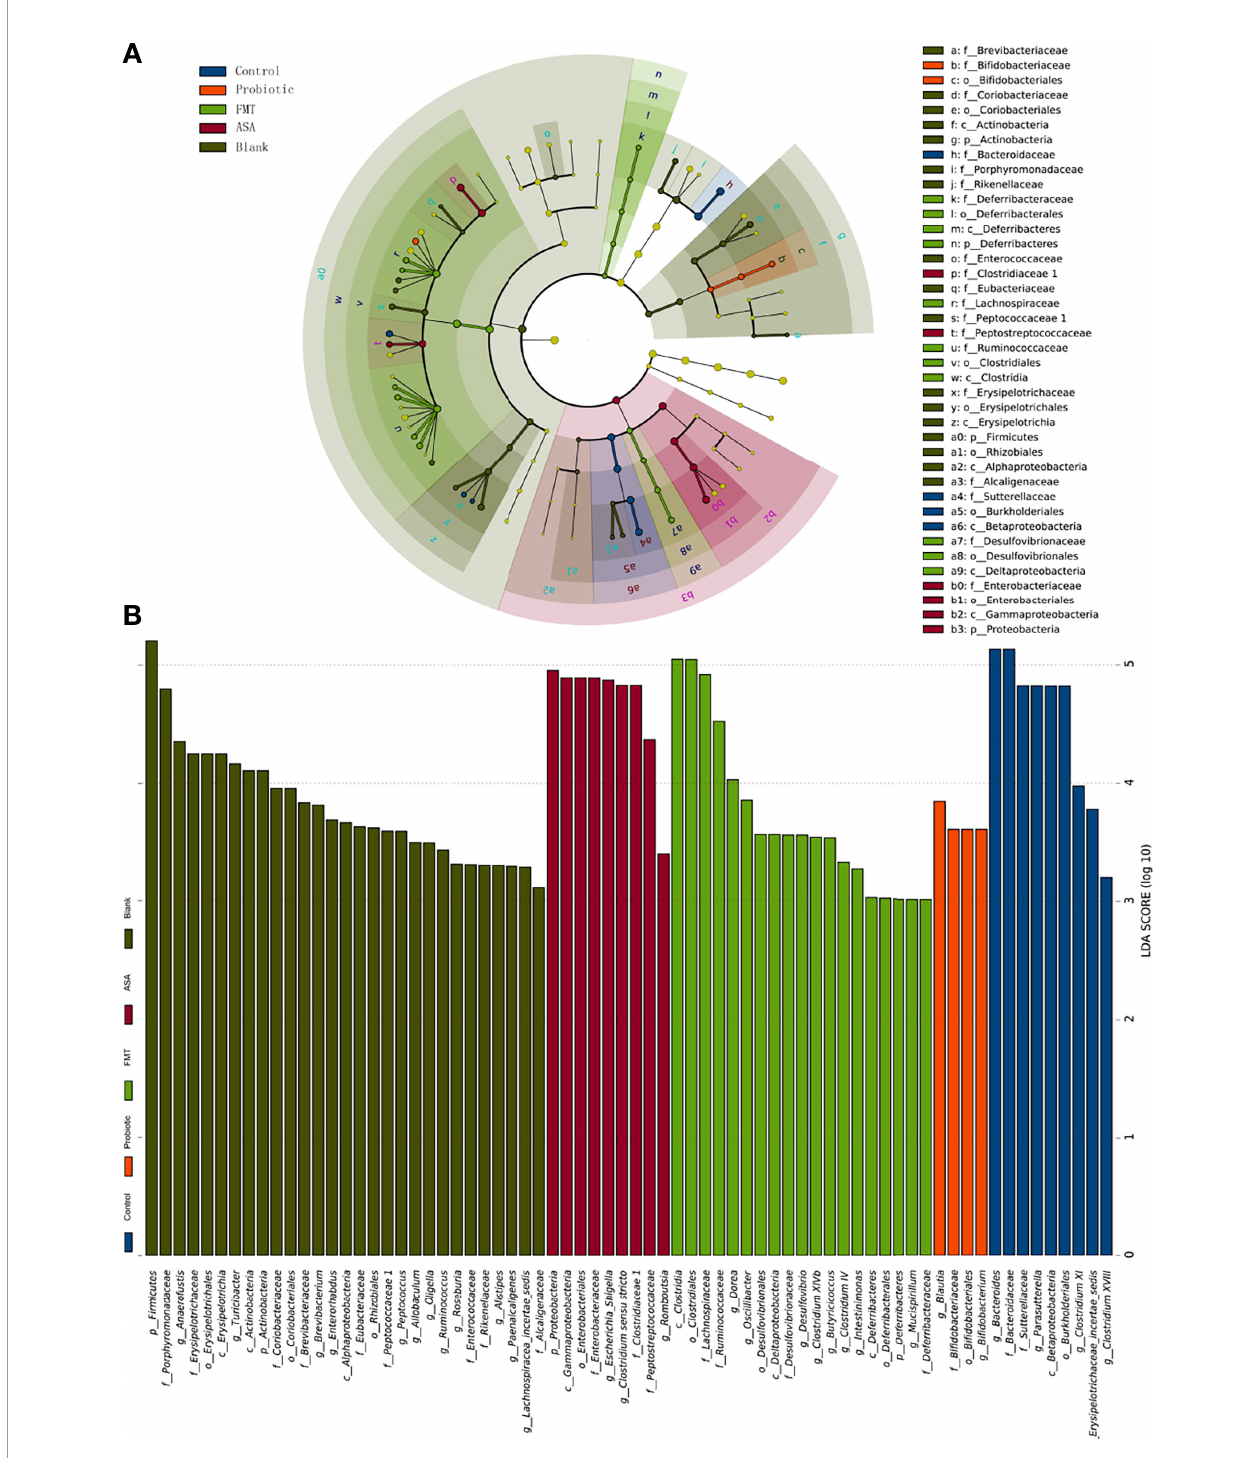
FIGURE 4 | The result of linear discriminant analysis integrated with effect size (LEfSe). The phylogenetic distribution in blank mice, and DSS-induced colitis mice treated with PBS, healthy mice donor FMT, 5-ASA, or the probiotic cocktail was illustrated with a cladogram (A) and a histogram (B) . DSS, dextran sodium sulfate; PBS, phosphate buffered saline; FMT, fecal microbiota transplantation; 5-ASA, 5-aminosalicylic